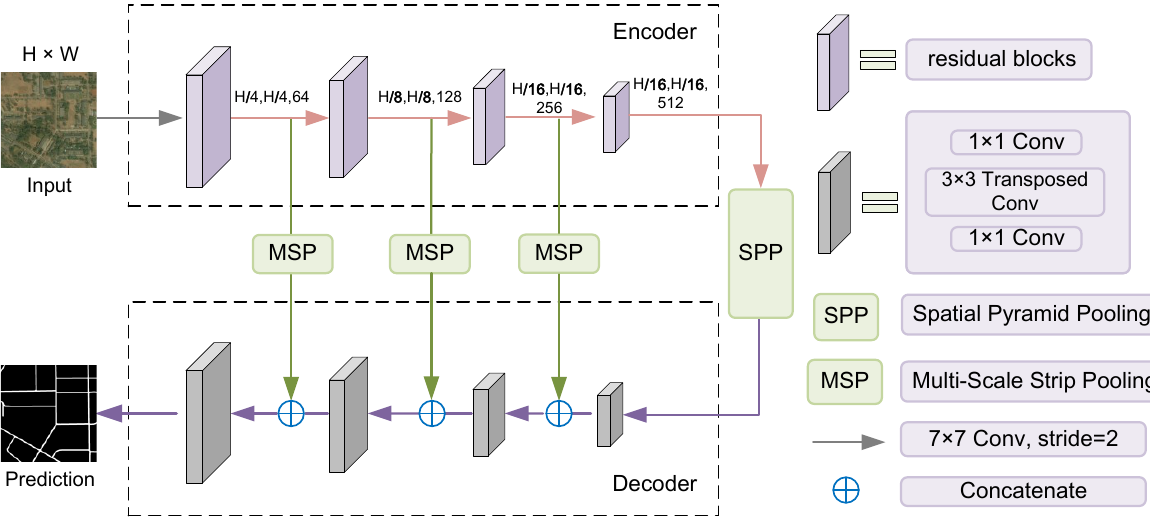
Figure 3. Overall architecture of the proposed multi-scale strip pooling network (MSPNet). The encoder module contains four residual blocks, the MSP module is applied to extracting linear features of the roads, and the PPM module is used to learn complex features from different scales. The decoder module is applied for gradually upsampling the resolution of the output feature map to get the final per-pixel